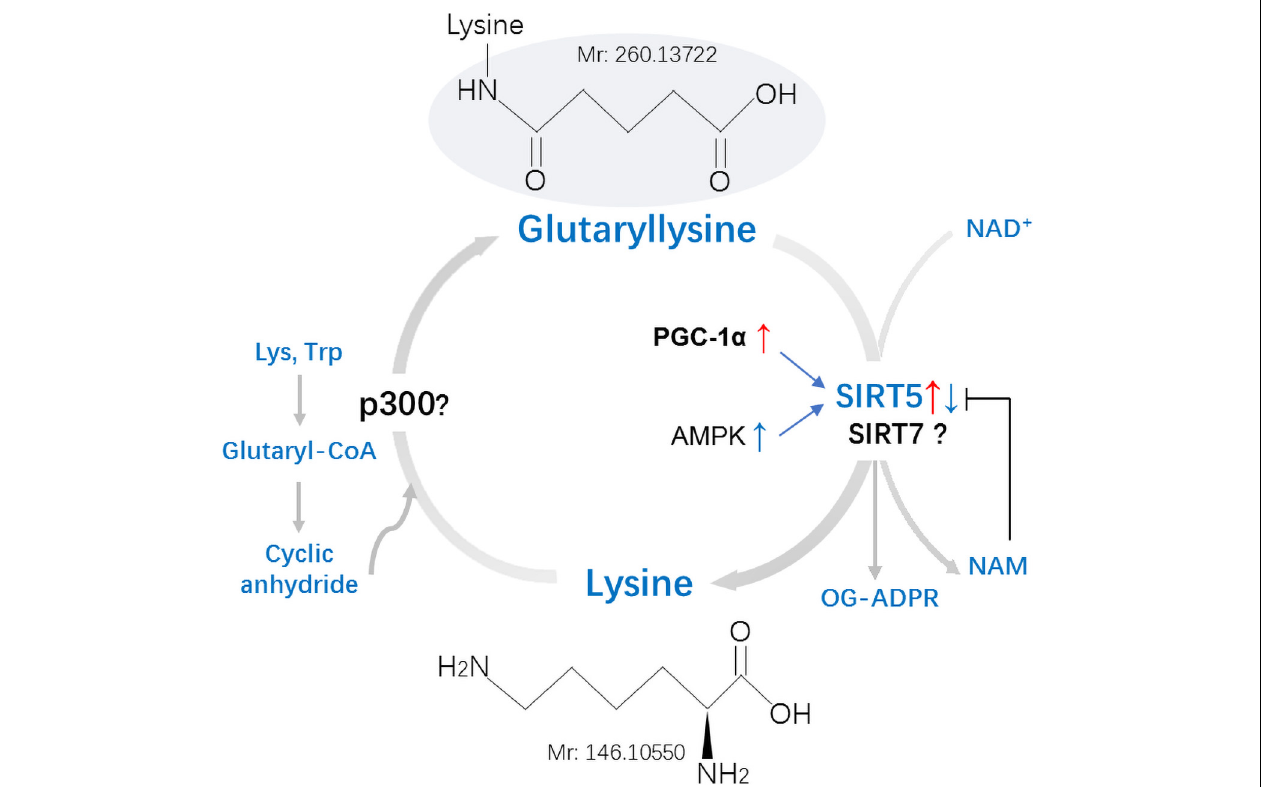
FIGURE 3 | Mechanisms and regulation of non-histones lysine glutarylation (Kglu). Glutaryl-CoA forms a reactive cyclic anhydride that readily glutarylates lysine residues on target proteins. No enzymes were found in this process in vivo . Whether the p300 is involved in the process of Kglu remains to be identified. Kglu is targeted for removal by the NAD + -dependent SIRT5. Expression of SIRT5 can be inhibited by NAM and be regulated by PGC-1 α and AMPK. Whether the SIRT7 possesses potent deglutarylase activities remains to be verified in vivo . Lys, Lysine; Trp, Tryptophan; NAM, Nicotinamide; OG-ADPR, O-Glutaryl ADP-Ribose;